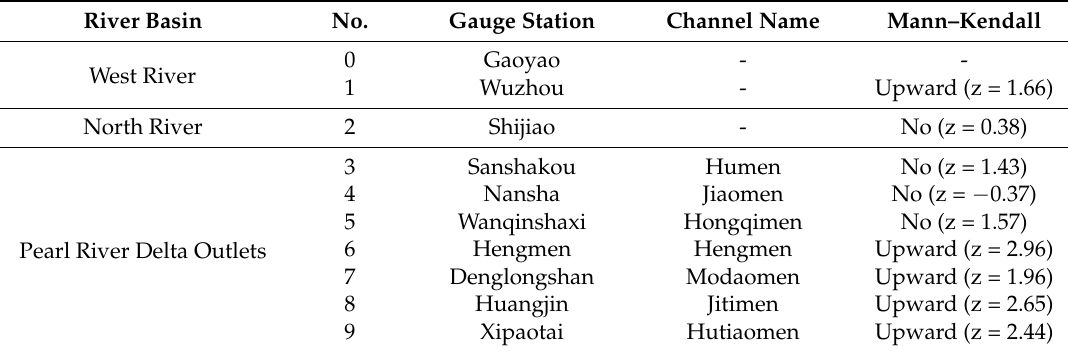
Table 1. Gauge stations and trend detection.